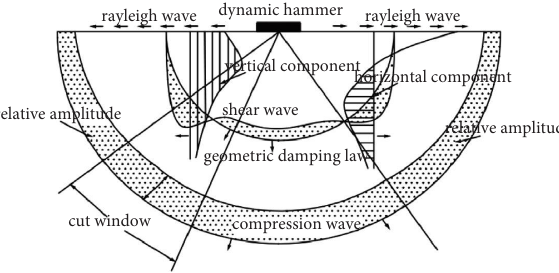
Figure 2: Propagation of shock kinetic energy in soil.